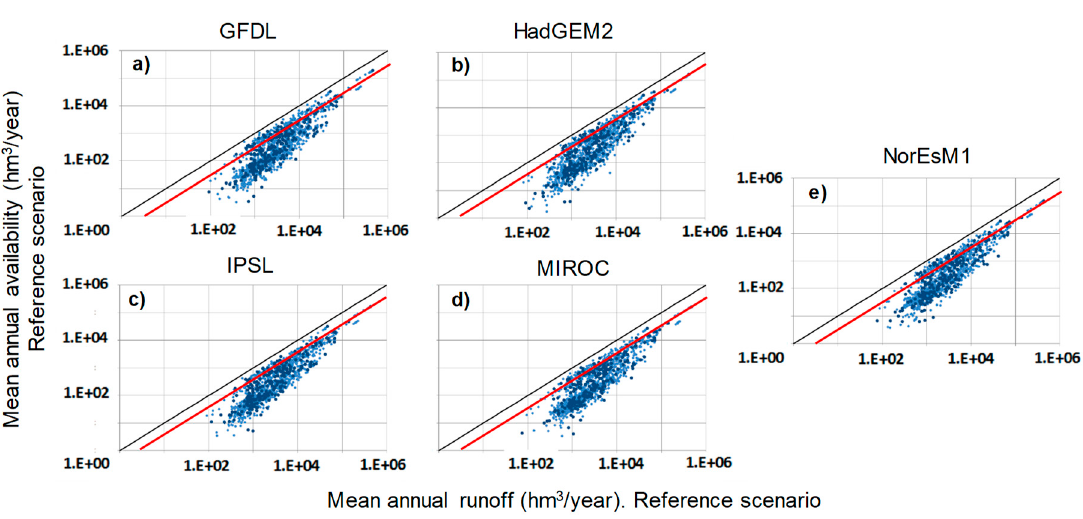
Figure 5. Mean annual water availability as a function of mean annual flow for the historical period (1960–1999) and for the different climate models. Small, blue dots represent results in intermediate sub-basins, while larger, darker blue dots represent results in the global river basins. Red line shows the value of 40% of mean annual runoff. ( a ) GFDL model, ( b ) HadGEM2, ( c ) IPSL, ( d ) MIROC and ( e ) NorEsM1.